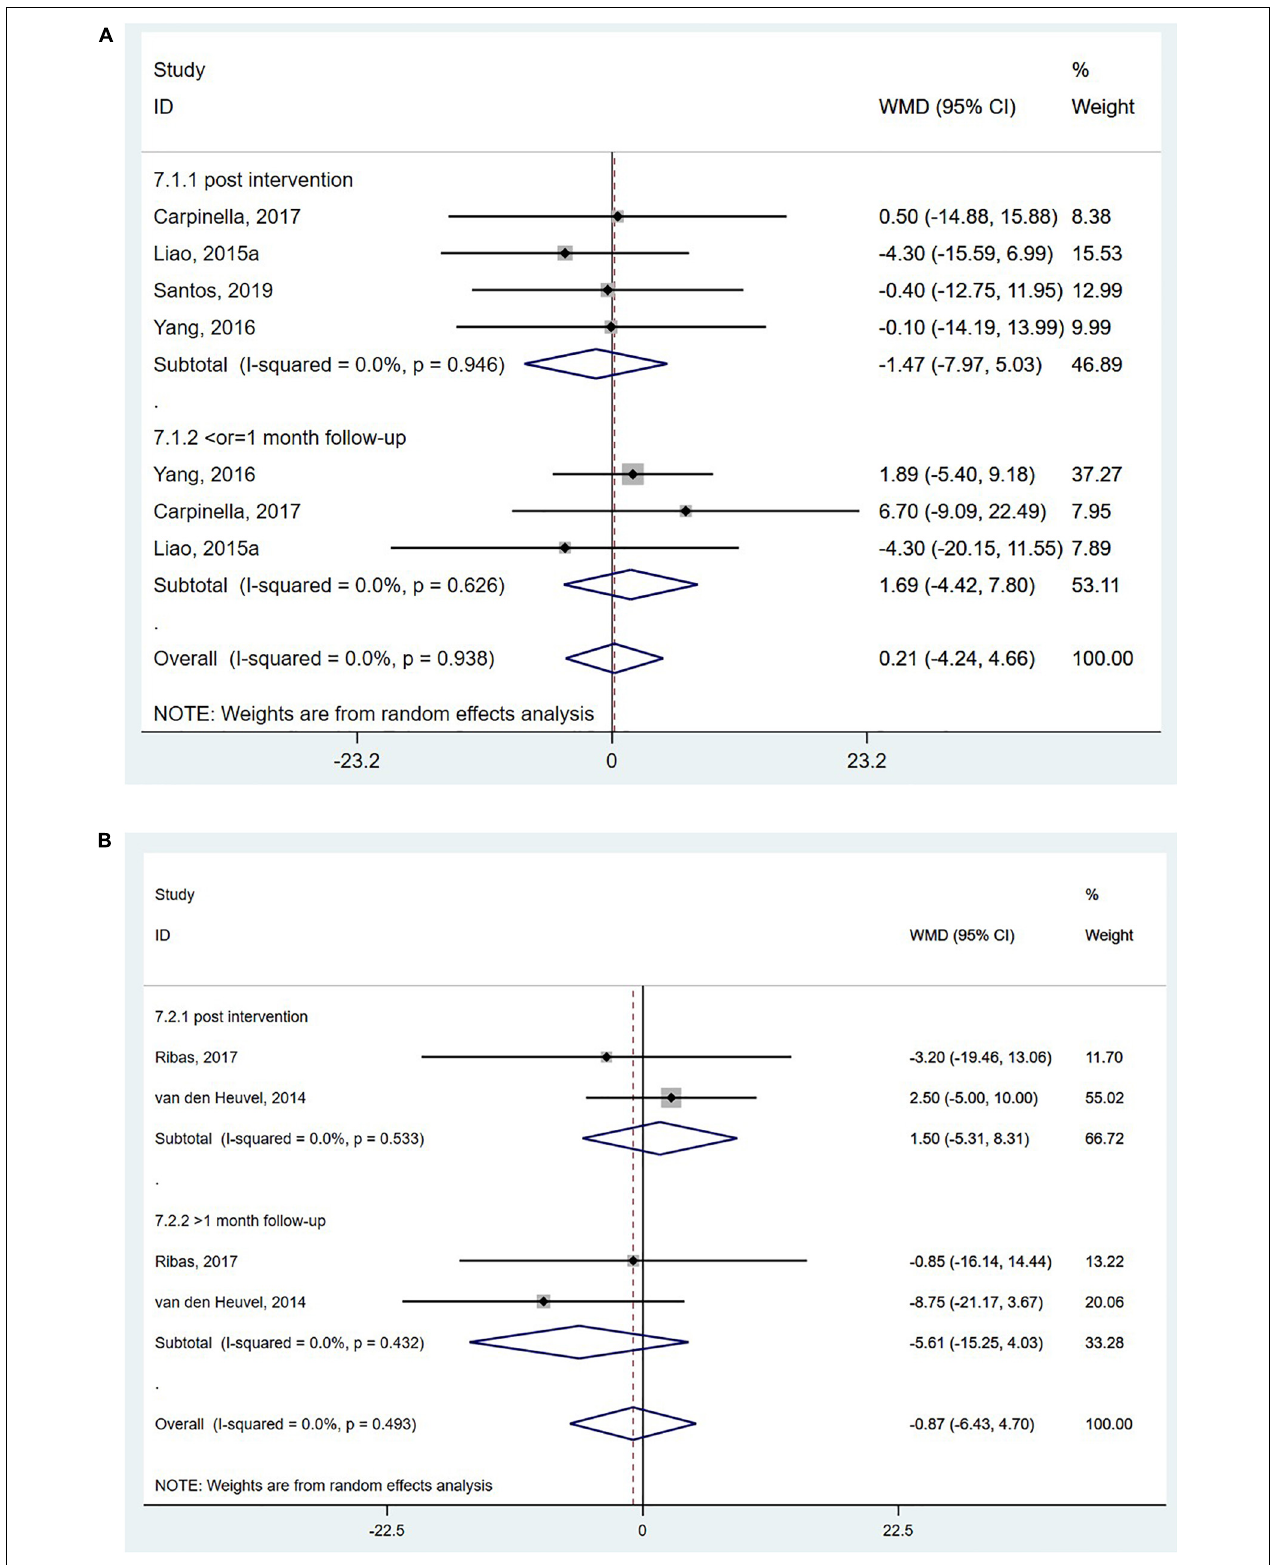
FIGURE 7 | Forest plot of pooled results for (A) the total score of 39-item Parkinson’s disease questionnaire and (B) the mobility scores of the 39-item Parkinson’s disease questionnaire.